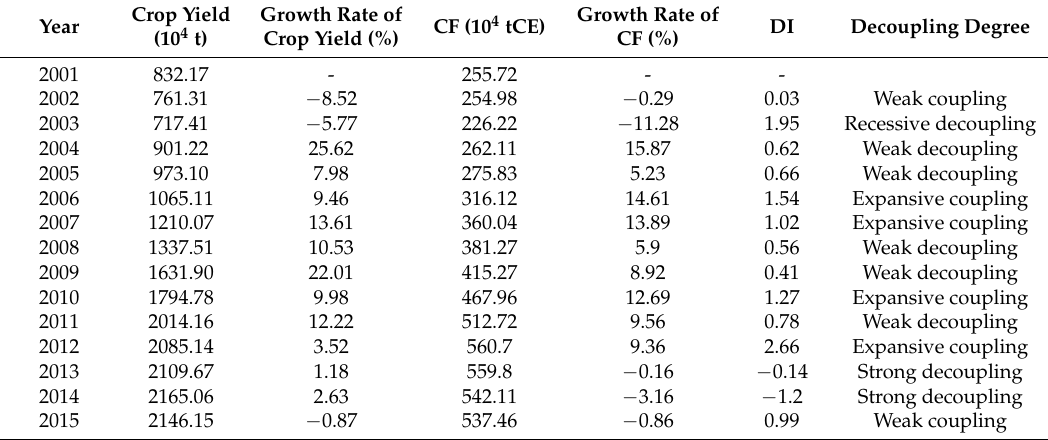
Table 3. Decoupling GHG emissions from crop production in the HLRA.